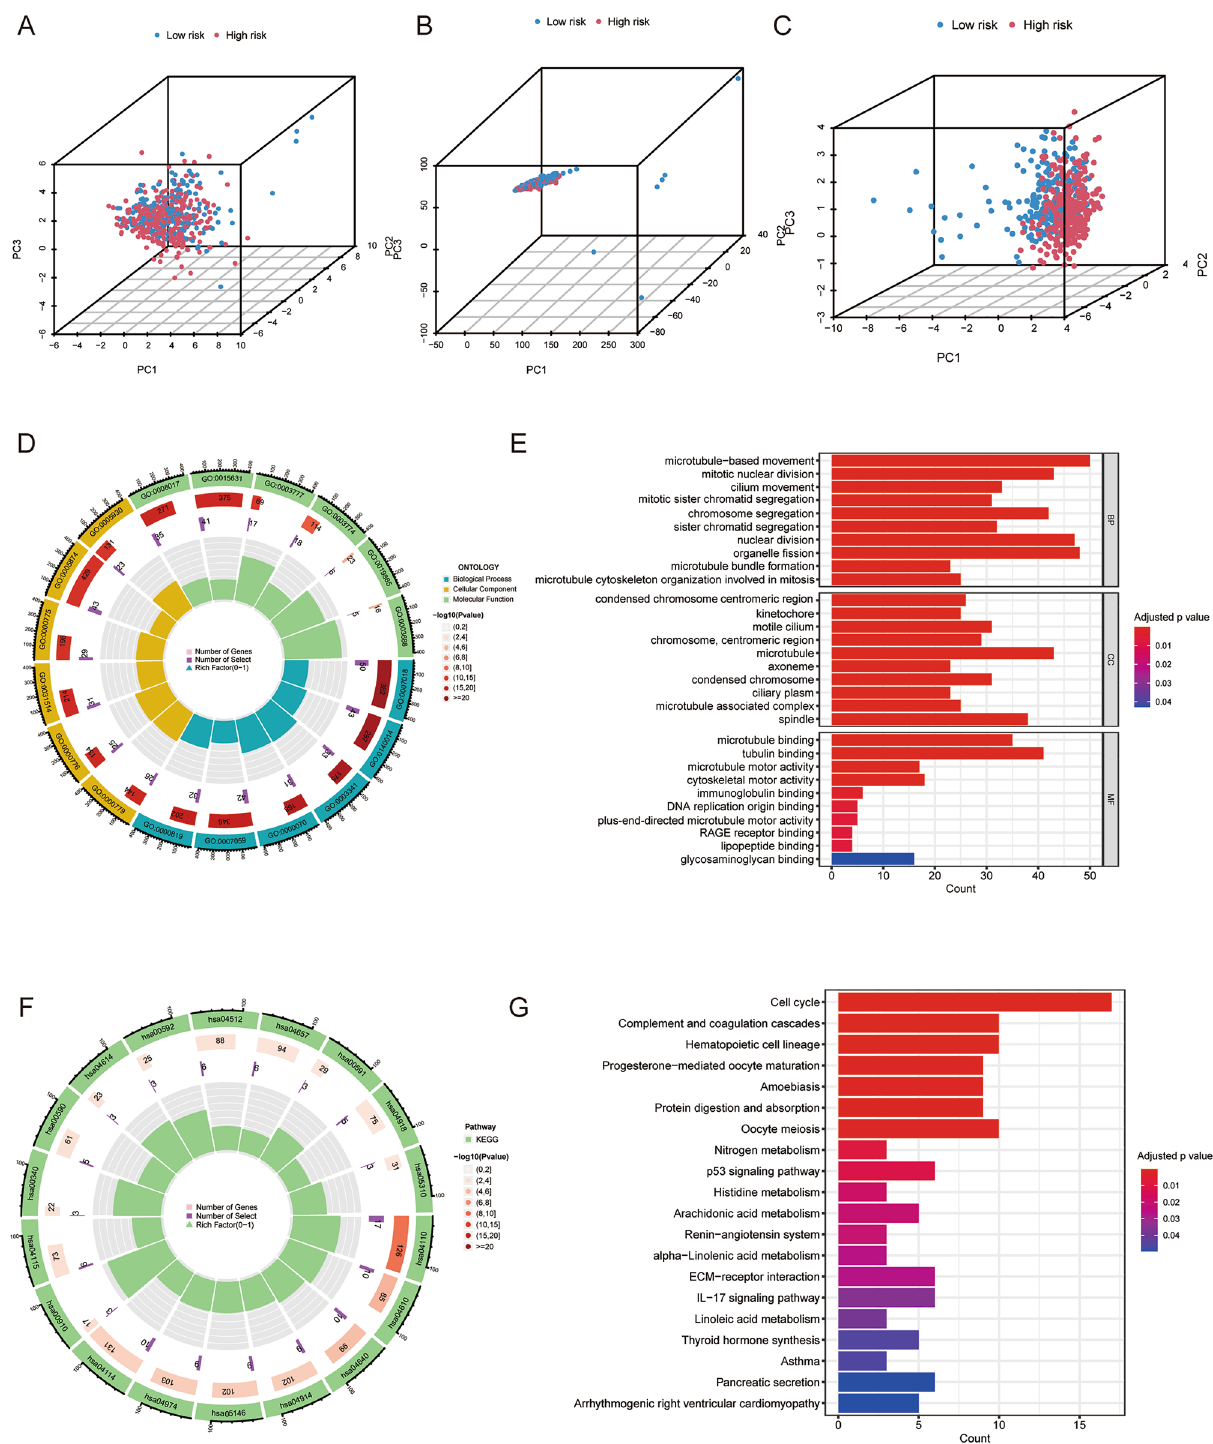
Figure 4. Principal component analyses (PCA) and representative results of functional enrichment analysis. PCA showing the distribution differences between the high- and low-risk groups using cuproptosis-related genes ( A ), cuproptosis-related lncRNAs ( B ) and risk-associated lncRNAs ( C ). ( D & E ) GO analysis of biological functions of differentially expressed genes between the high- and low-risk groups. ( F & G ) KEGG analysis of biological functions of differentially expressed genes between the high- and low-risk